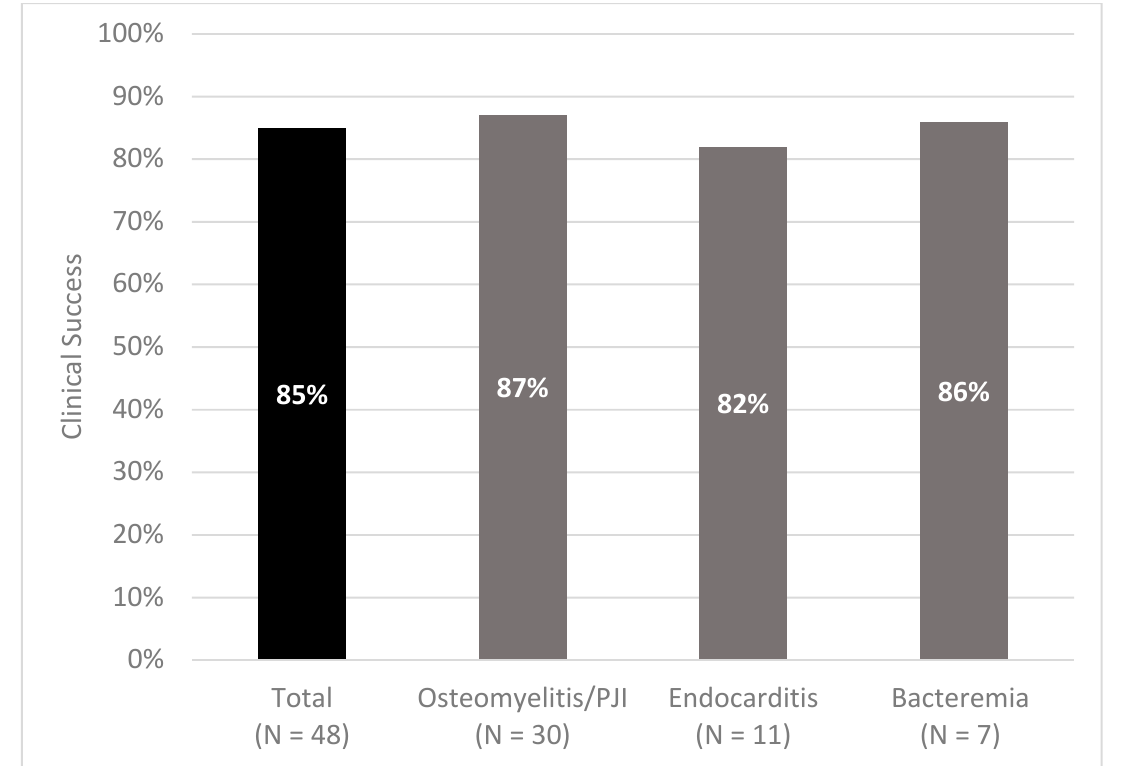
Figure 2. Clinical Success at 90 Days by Indication.